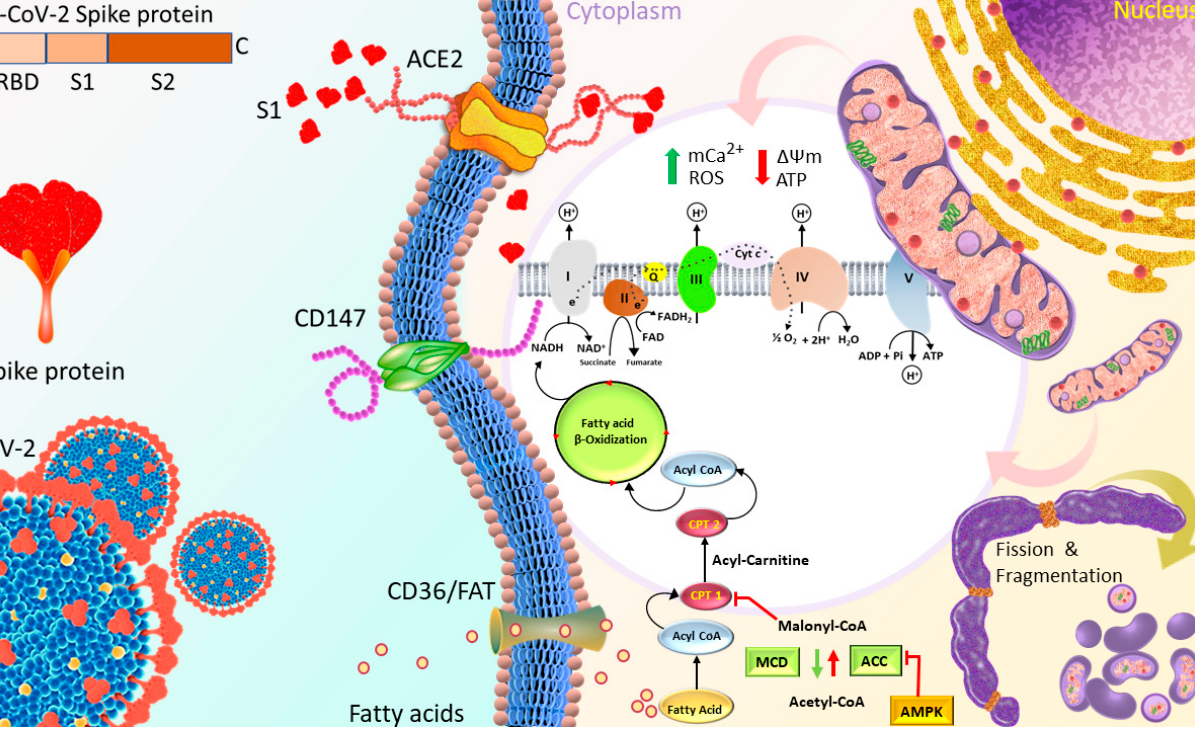
Figure 8. Proposed mechanisms through which S1 induced cardiac mitochondrial dysfunction which leads to cardiac injury in COVID-19 patients. Spike protein is the glycosylated protein that covers the surface of SARS-CoV-2 and binds to the host ACE2 receptor to mediate the viral cell entry. It is composed of S1 and S2 subunits that are responsible for ACE2 binding and membrane fusion, respectively. S1 possibly binds to ACE2 on the AC16 membrane, and is then internalized into the cytosol and localized in organelles, such as mitochondria, which induces the transient increase in fatty acids transport and uptake for biogenetics, ∆ ψ m, and permanent mCa 2+ , and disrupts ∆ ψ m later, finally impairing mitochondrial function and promoting ROS production. In turn, ROS further exacerbates mitochondrial function and mitochondrial fragmentation. Moreover, S1 also causes downregulation of TOM20; this effect might inhibit the pathways leading to mitochondrial biogenesis. ACE2, angiotensin converting enzyme 2; FAT, fatty acid translocase; PCT1/2, Carnitine palmitoyltransferase 1/2; MCD, Malonyl-CoA Decarboxylase; ACC, acetyl-CoA carboxylase; AMPK, AMP-activated protein kinase; mCa 2+ , mitochondrial Calcium, ∆ ψ m, mitochondrial membrane potential; ROS, reactive oxygen